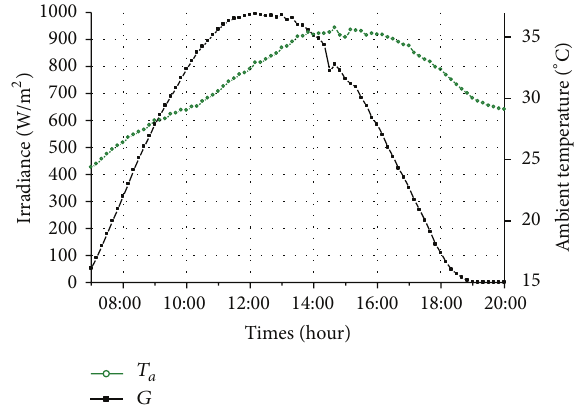
Figure 2: Global irradiance and temperature tests.